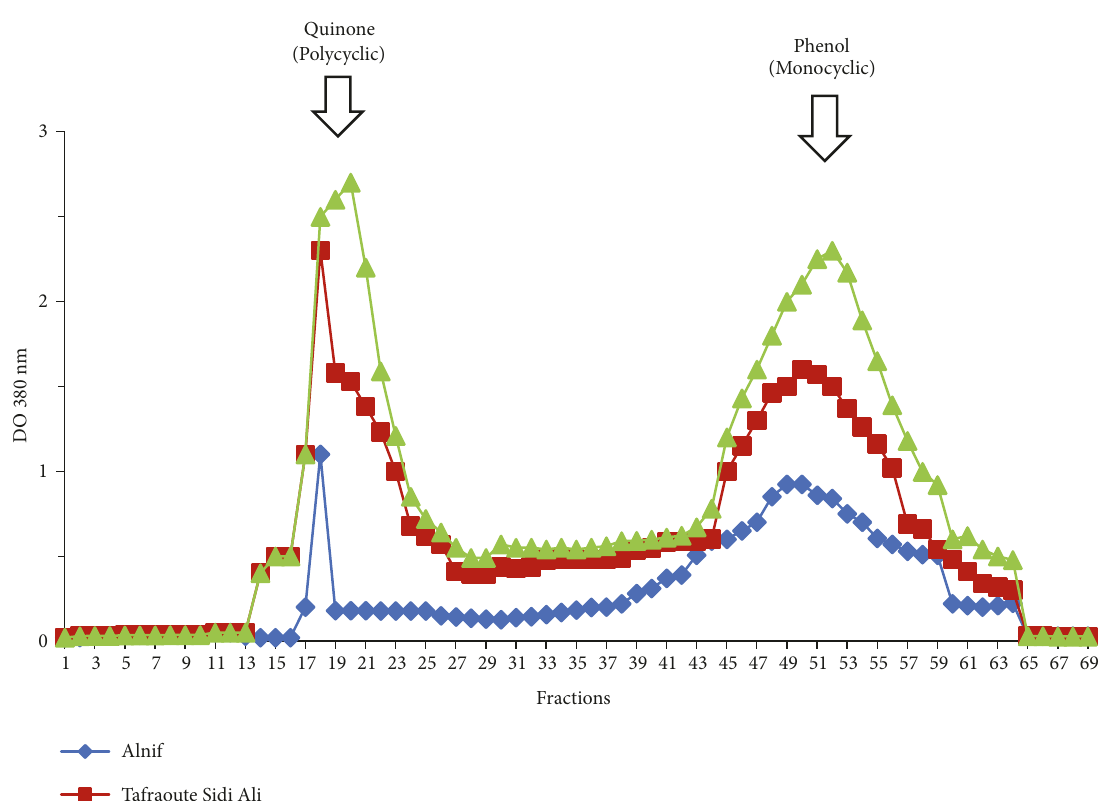
Figure 2: Molecular weight distribution of phenolic compounds of the three Henna varieties